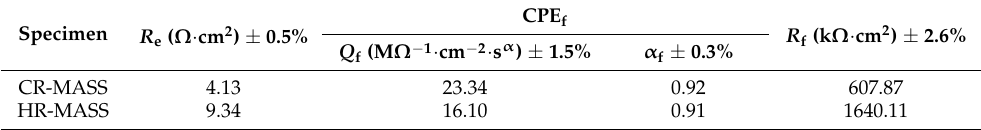
Table 3. Fitting results of the EIS parameters for the experimental MASS according to the equivalent circuits.